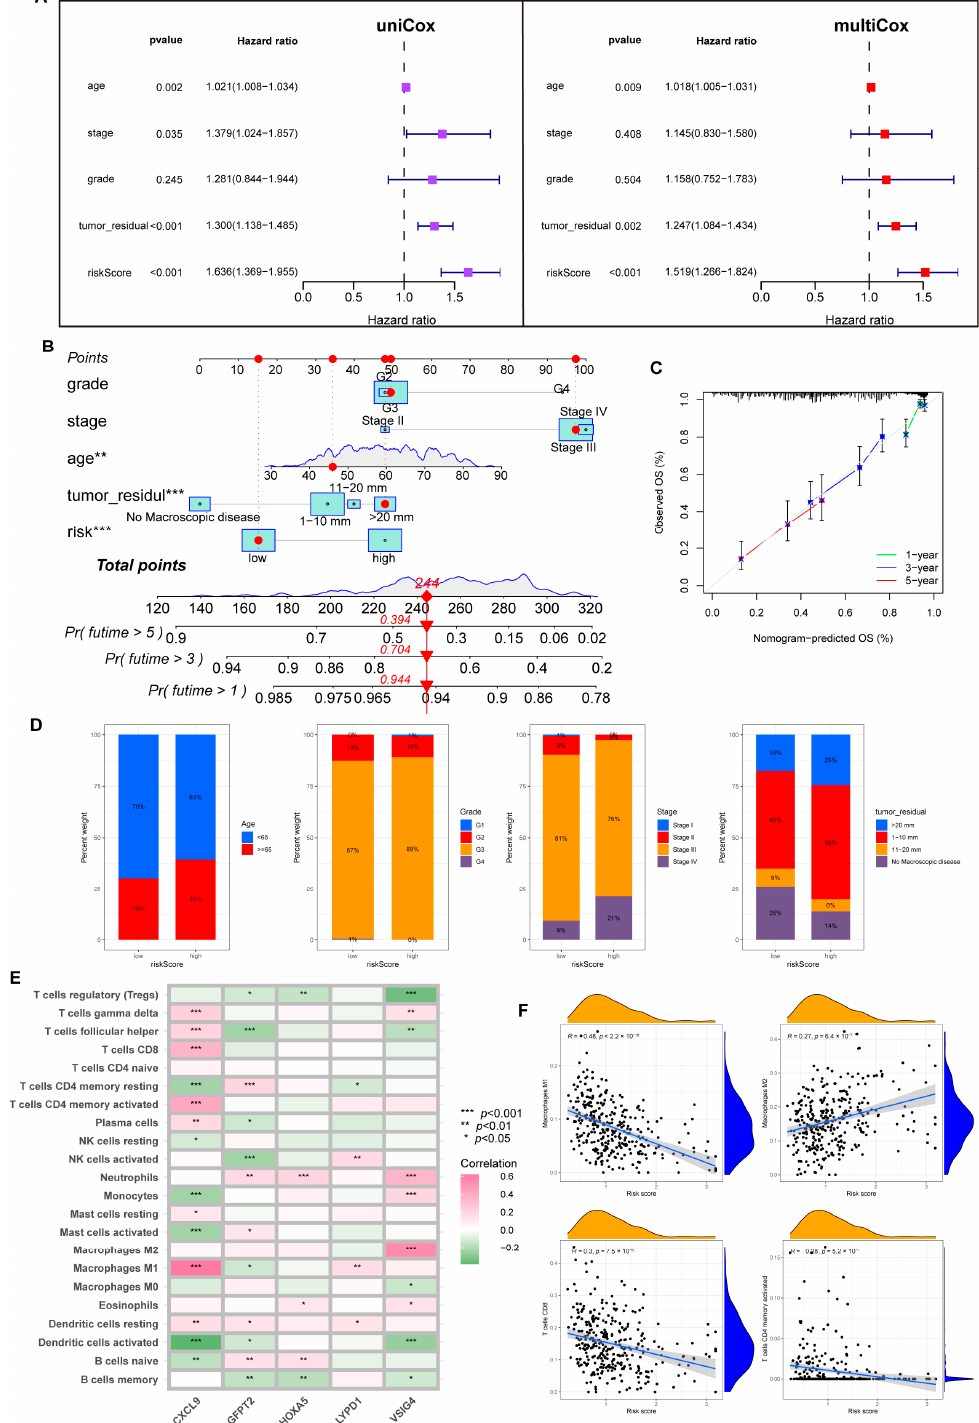
Figure 6. The predictive value of the risk model. ( A ) Uni-Cox and multi-Cox analysis between OS and related factors. ( B ) A nomogram was established for OS prediction. ( C ) Calibration curve for evaluating nomogram performance. (* p < 0.05; ** p < 0.01; *** p < 0.001). ( D ) Overview of clinical information for different risk individuals. ( E ) Correlation of five hub genes and immune cell infiltration. ( F ) Risk score correlation of immune infiltration abundance.